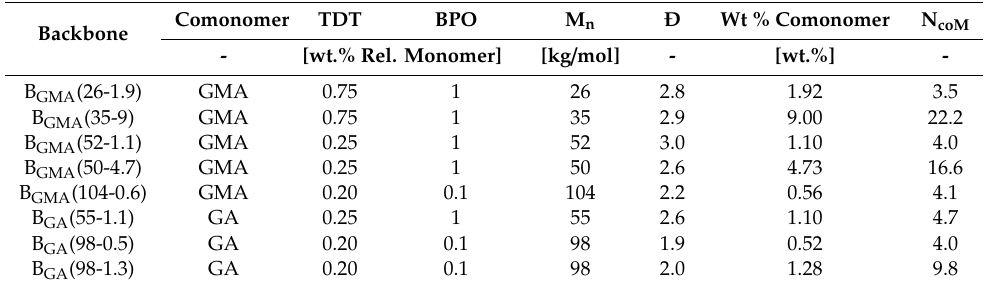
Table 1. Structural variations for the synthesis of PBA-co-GA or